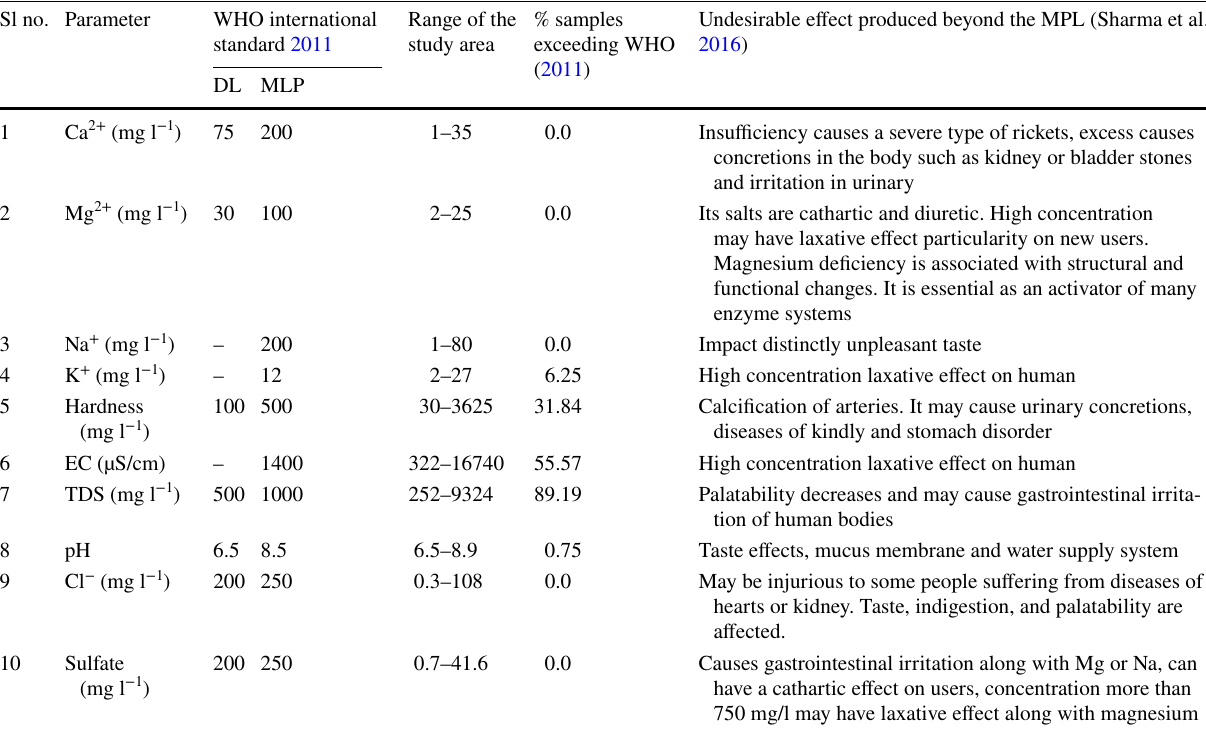
Table 5 Groundwater sample of the study area exceeding the permissible limits recommended by WHO (2011) for drinking purpose